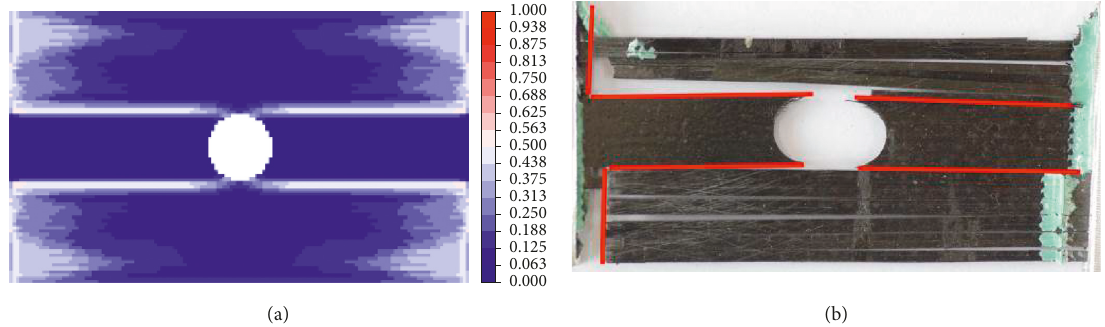
Figure 16: Failure morphology of UD reinforced lamina with circle crack. (a) PD result. (b) Experiment.